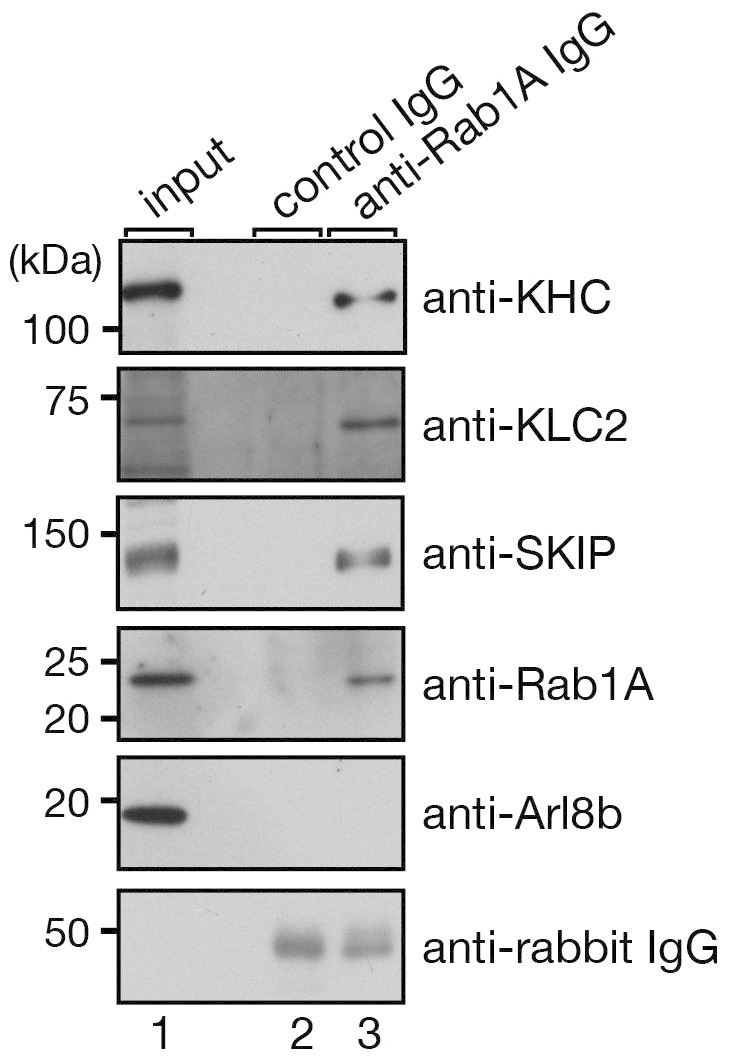
Formation of the Rab1A–SKIP–kinesin-1 complex in melan-a cells.Endogenous Rab1A molecules were immunoprecipitated from lysates of melan-a cells with anti-Rab1A specific IgG (lane 3) or control IgG (lane 2). Rab1A, SKIP, KLC2, kinesin heavy chain (KHC), and Arl8b were analyzed by immunoblotting with specific antibodies. The amount of IgG heavy chain used for immunoprecipitation was analyzed with an anti-rabbit IgG antibody (bottom panel). It should be noted that SKIP, KLC2, and KHC (Kif5b) were co-purified with Rab1A, but Arl8b was not. Input shows a 1/140 volume of the reaction mixture used for immunoprecipitation. The positions of the molecular mass markers are shown on the left.